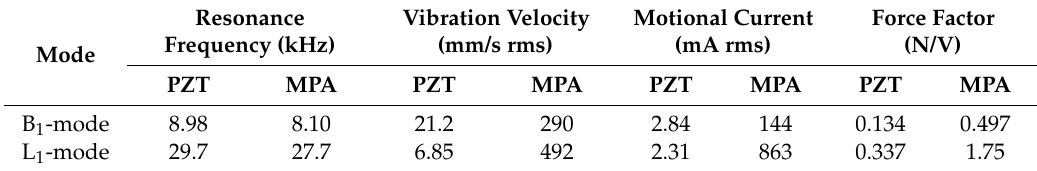
Table A2. Results of force factor measurement of PZT and MPA type vibrators.